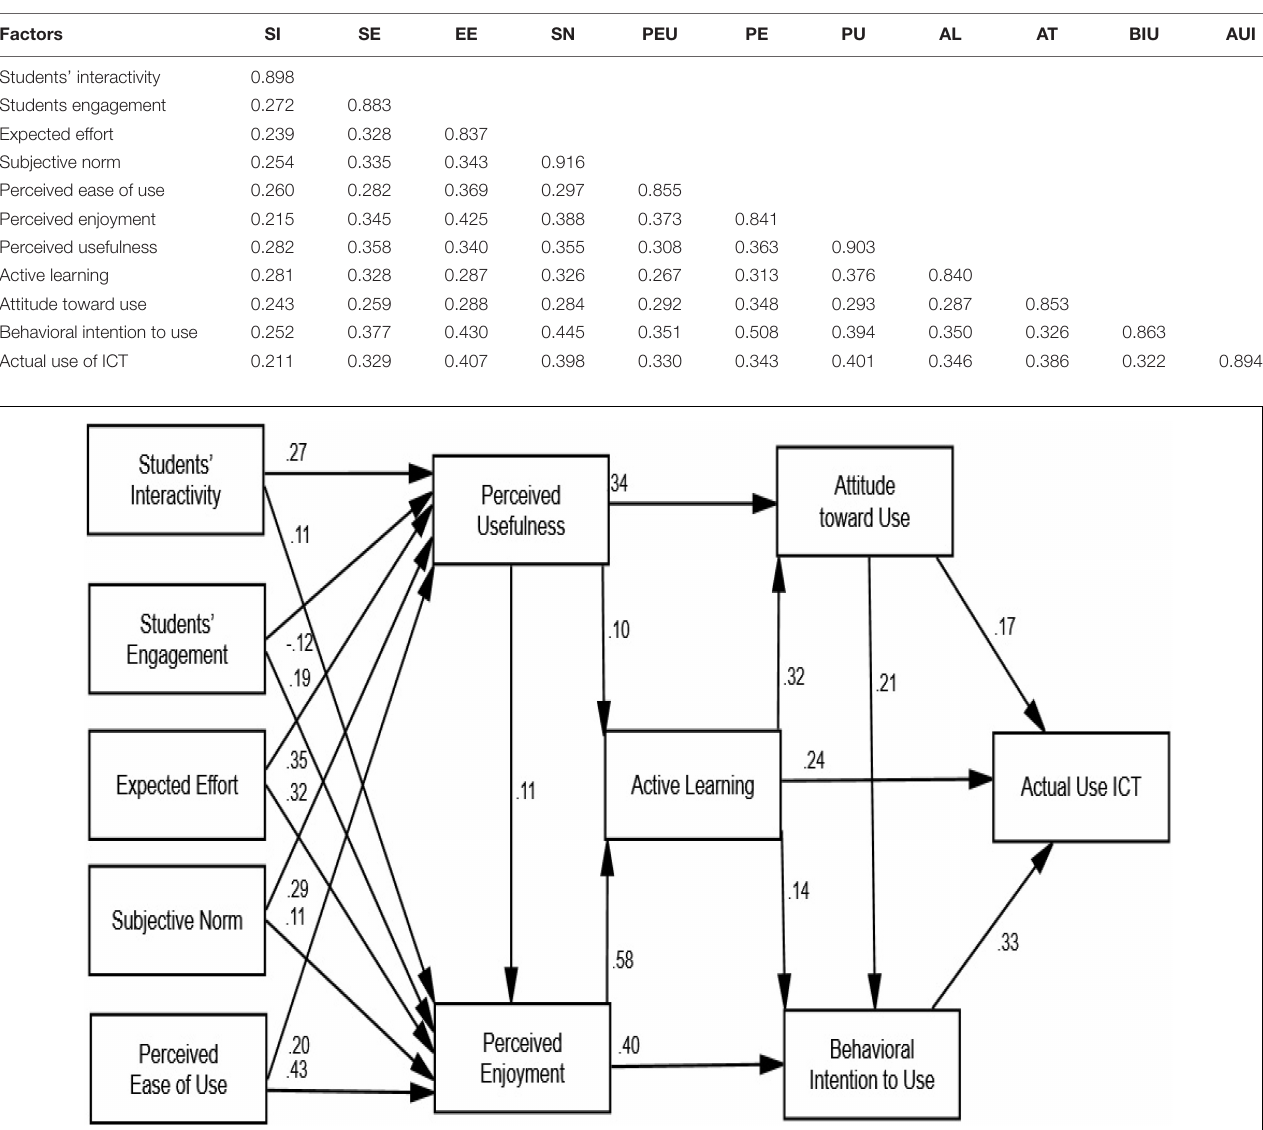
TABLE 5 | Discriminant validity.